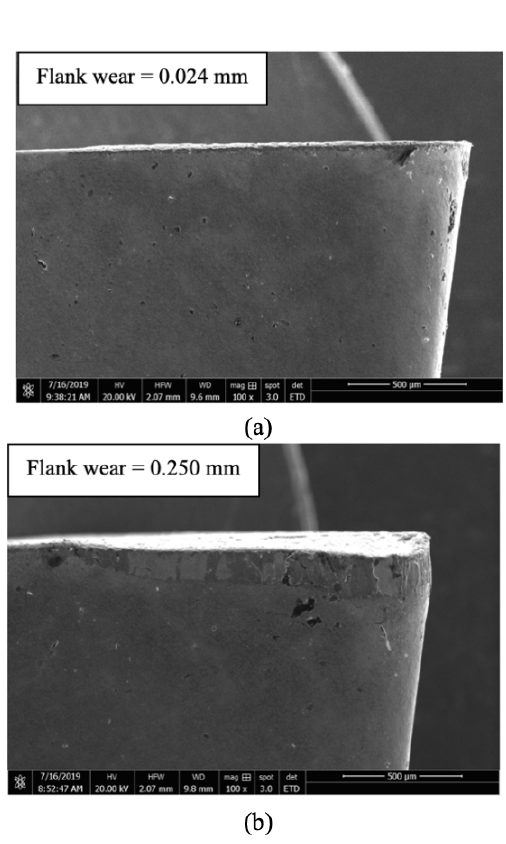
Figure 10. Scanning electron microscopy images. (a) Min wear at f = 0 . 12, v = 50, d = 1, cryogenic. (b) Max wear at f = 0 . 2, v = 150, d = 1 . 5,